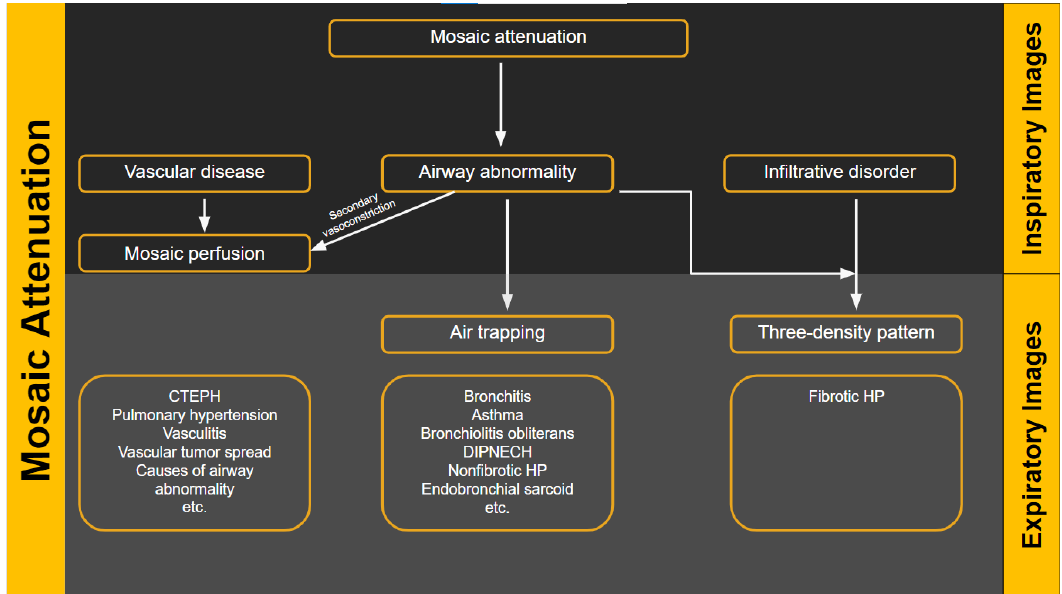
Figure 2. Flow diagram showing the heterogeneous lung attenuation patterns. Mosaic attenuation is a terminology reserved for inspiratory phase imaging and can be seen in vascular diseases, small airway disease or infiltrative diseases such as hypersensitivity pneumonitis. Mosaic perfusion is a feature of primary vascular disease but can also be seen with small airway disease due to hypoxic